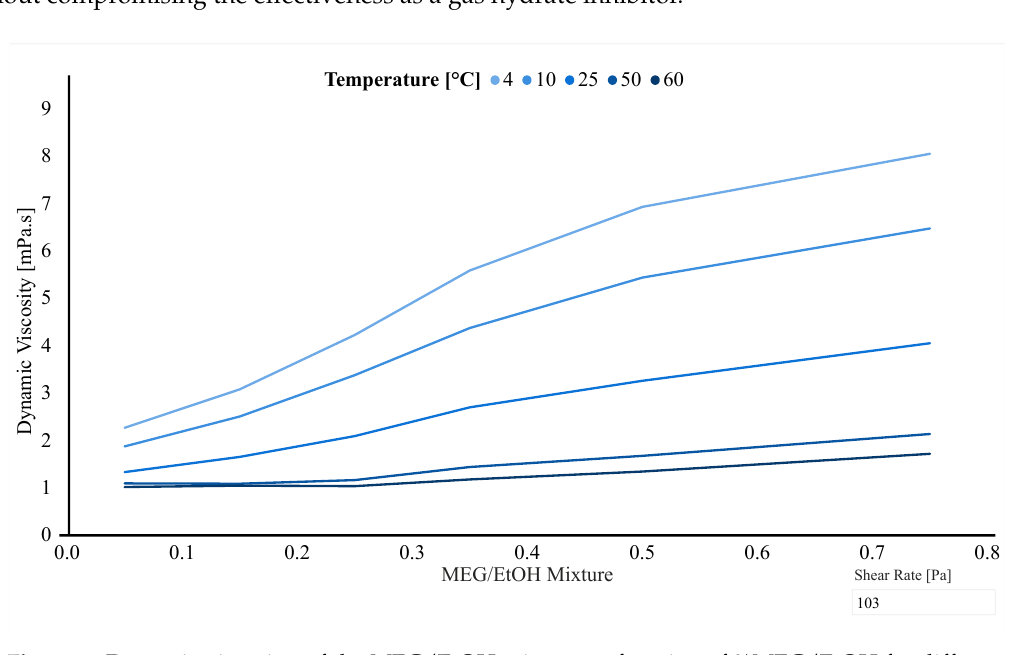
Figure 5. Dynamic viscosity of the MEG/EtOH mixture as function of %MEG/EtOH for different temperatures using a shear rate of 103